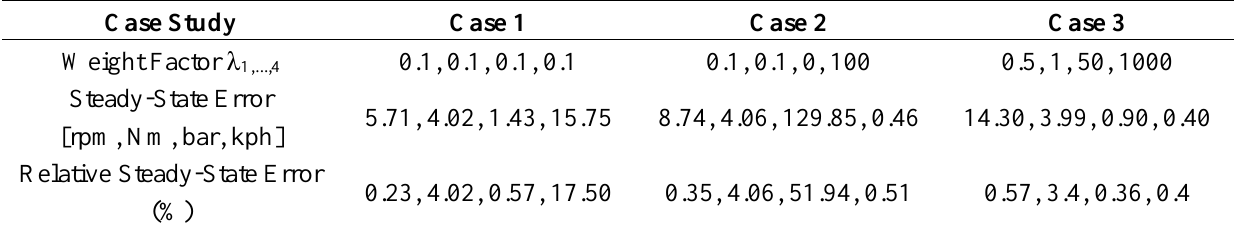
Table 3. Weight factors and steady-state